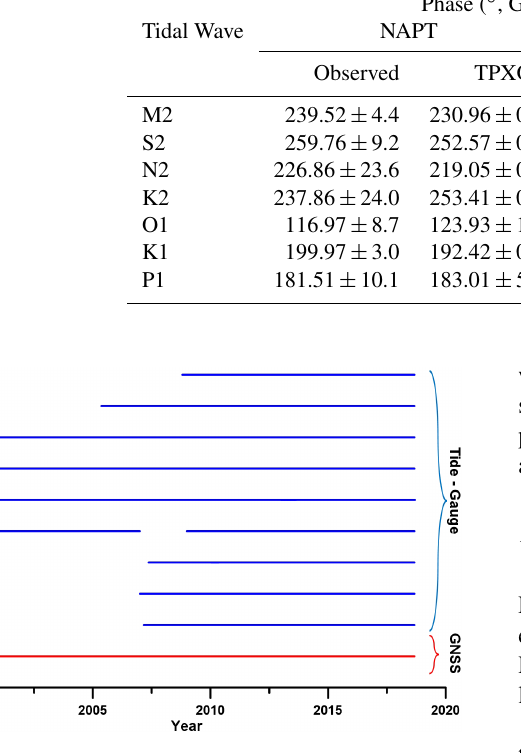
Figure 2. Consistency of the available data set. Red and blue lines indicate GNSS and tide gauges stations respectively. For clarity, the time interval covered by the two reference stations, NAPT and NAMM, is indicated only by name